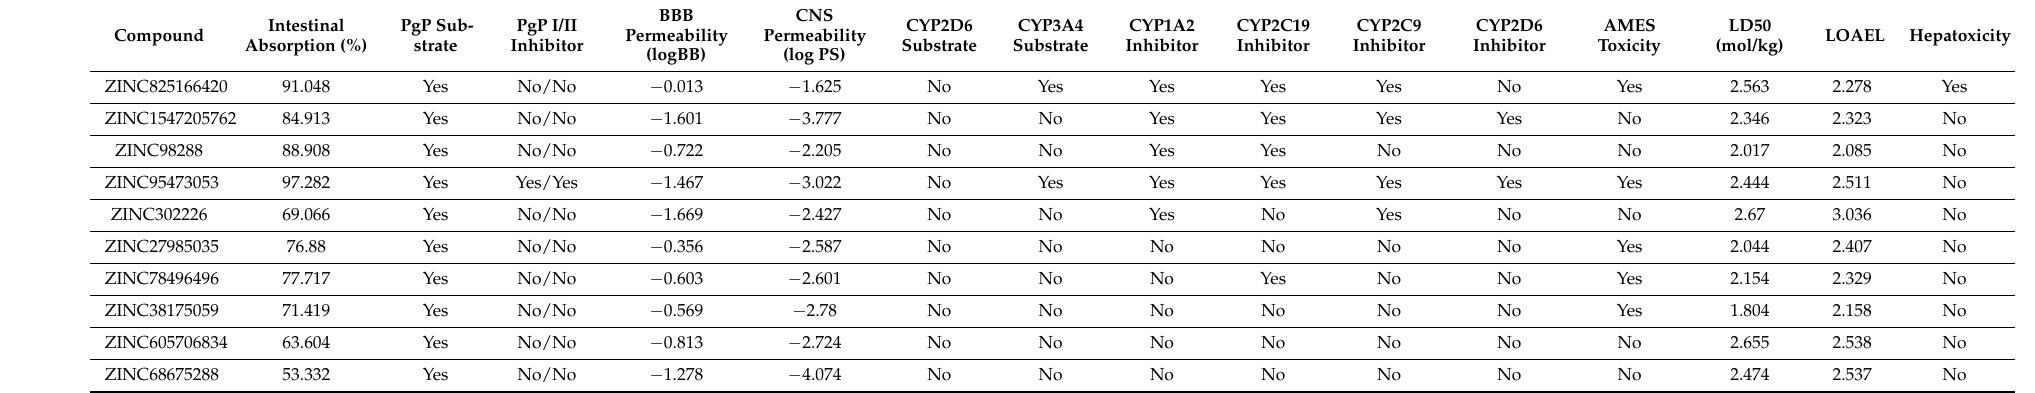
Table 2. ADMET prediction for the most promising